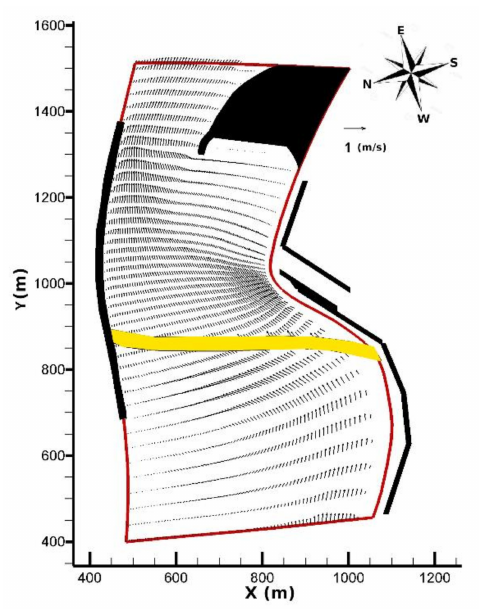
Figure 10. Calculated wave and depth averaged velocity field (one vector out of every four). Present sea bottom level. Configuration 2.